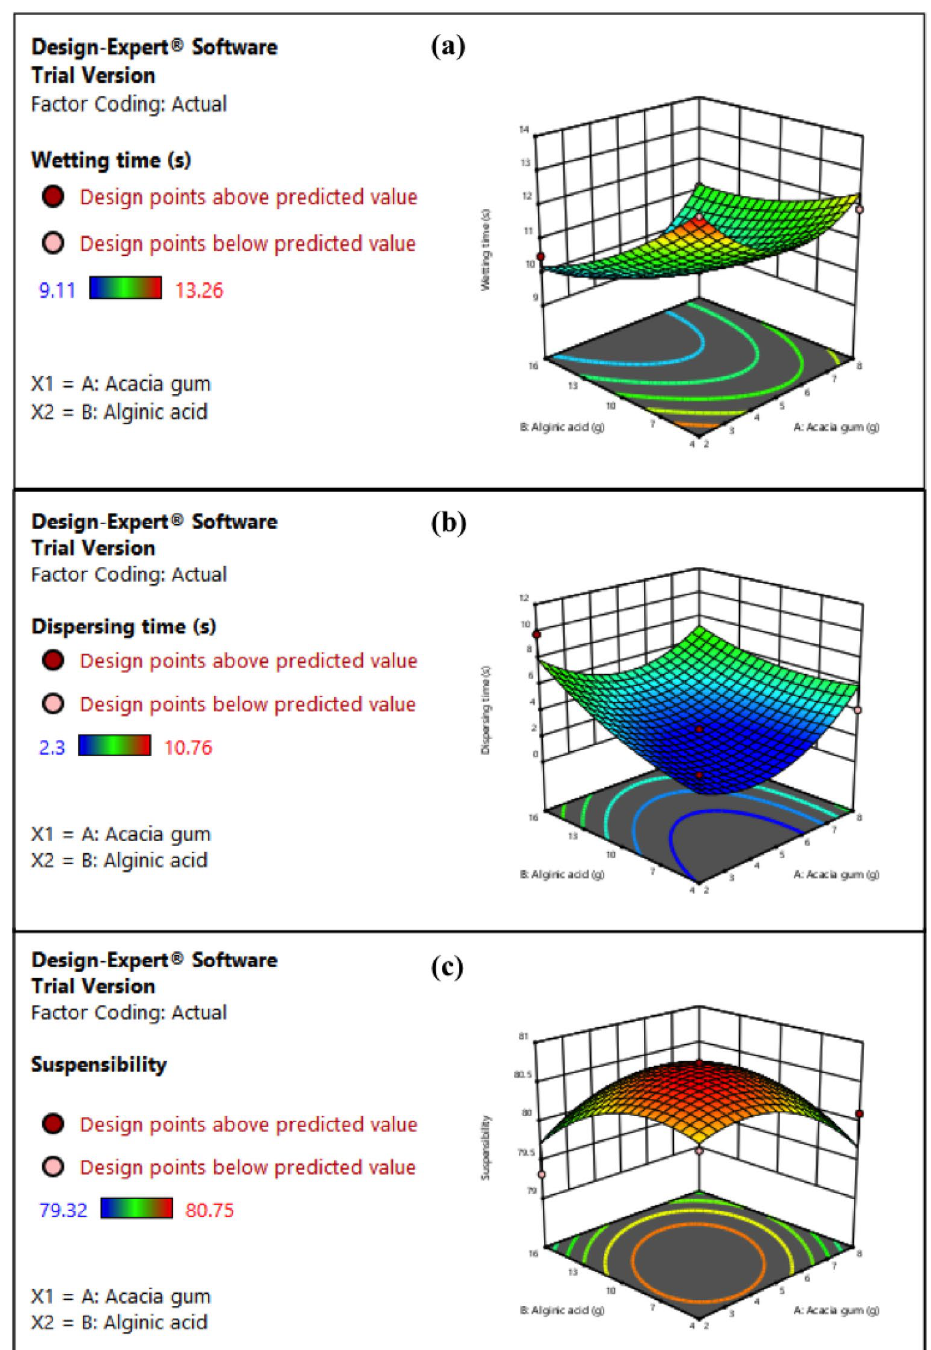
Figure 1. 3D response curve showing interaction between concentrations of acacia gum-A and alginic acid-B on ( a ) wetting time, ( b ) dispersing time, and ( c ) suspensibility of water dispersible